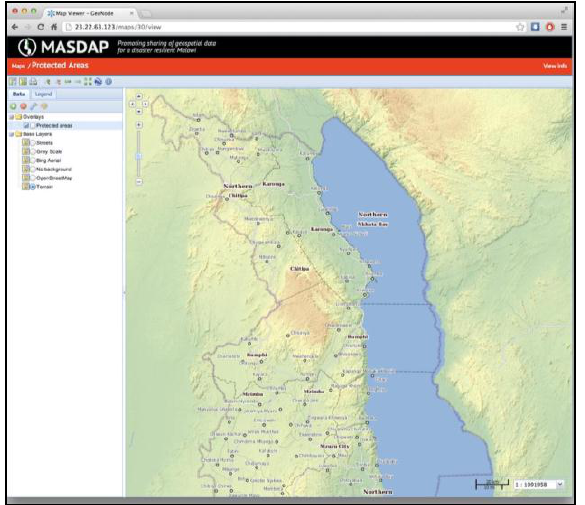
Figure 3. Screenshot of the map composer application of the MASDAP platform